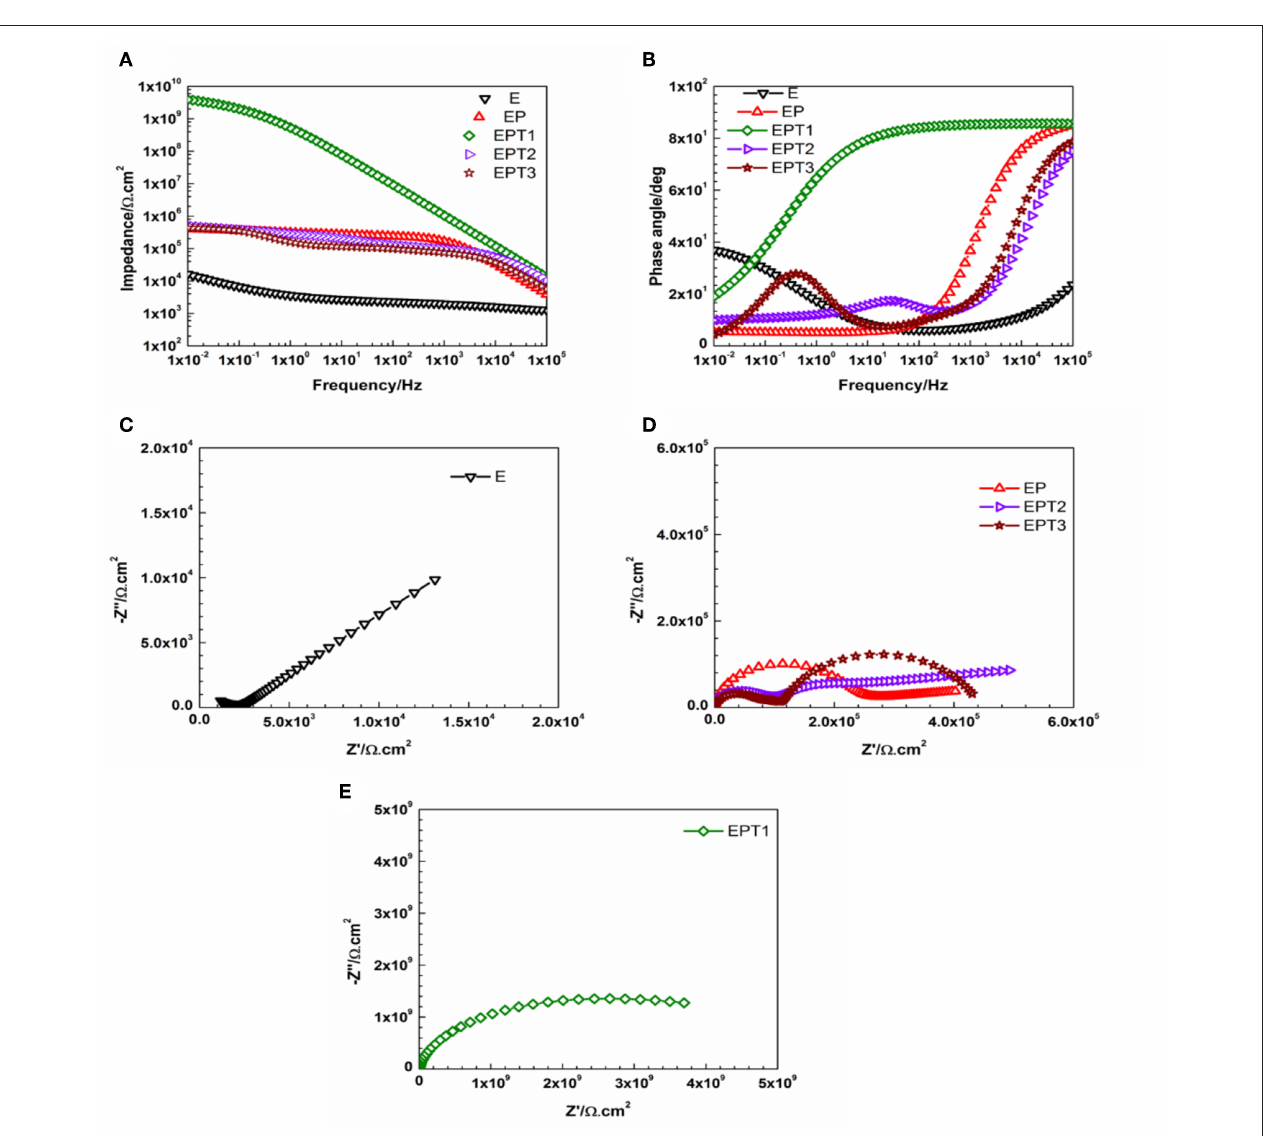
FIGURE 11 | Representative (A) Bode plots and (B) phase angle plots for E, EP, and all PDMS modified epoxy nanocomposite coatings, and Nyquist plots for (C) E, (D) EP, EPT2, and EPT3, (E) EPT1 coating systems after 30 days of immersion.